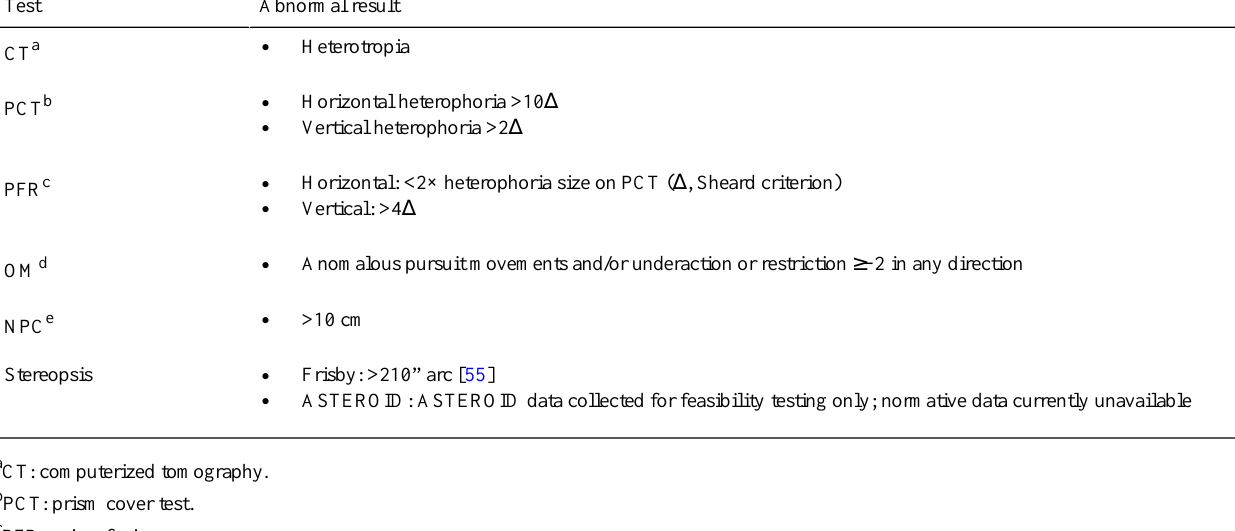
Table 2. Criteria for abnormal test results.